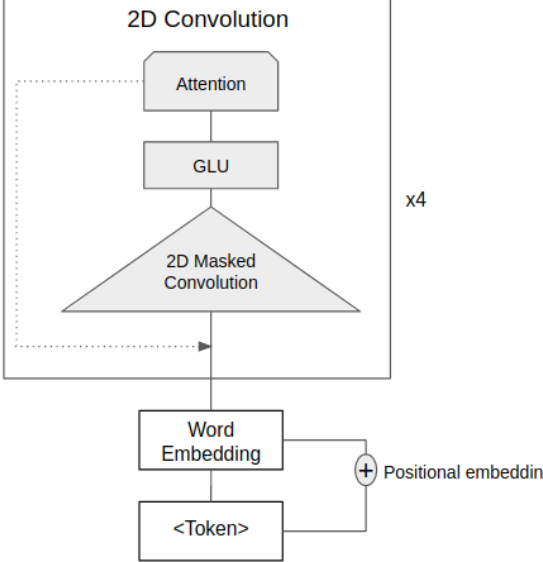
Figure 3. The detailed implementation of our 2D convolution. After receiving the output from word embedding, we apply a 2D masked convolutional layer followed by a gated linear unit and an attention layer. We stack this 2D convolution four times before applying output embedding to get the output word